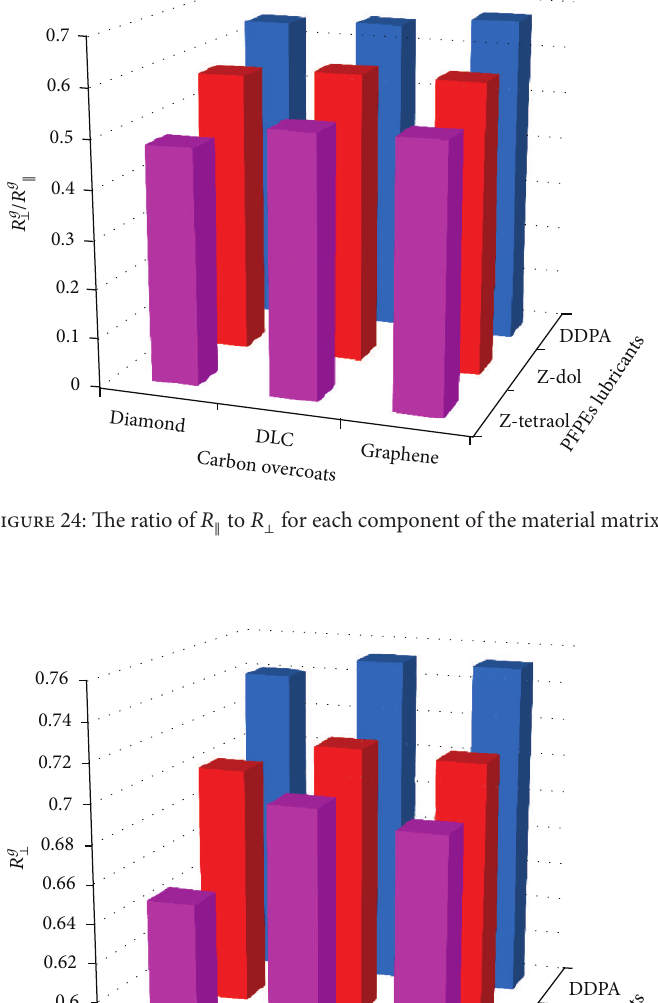
flexibility of arms and end-group interactions results in less flat molecular conformation as well as thicker film as shown in Figure